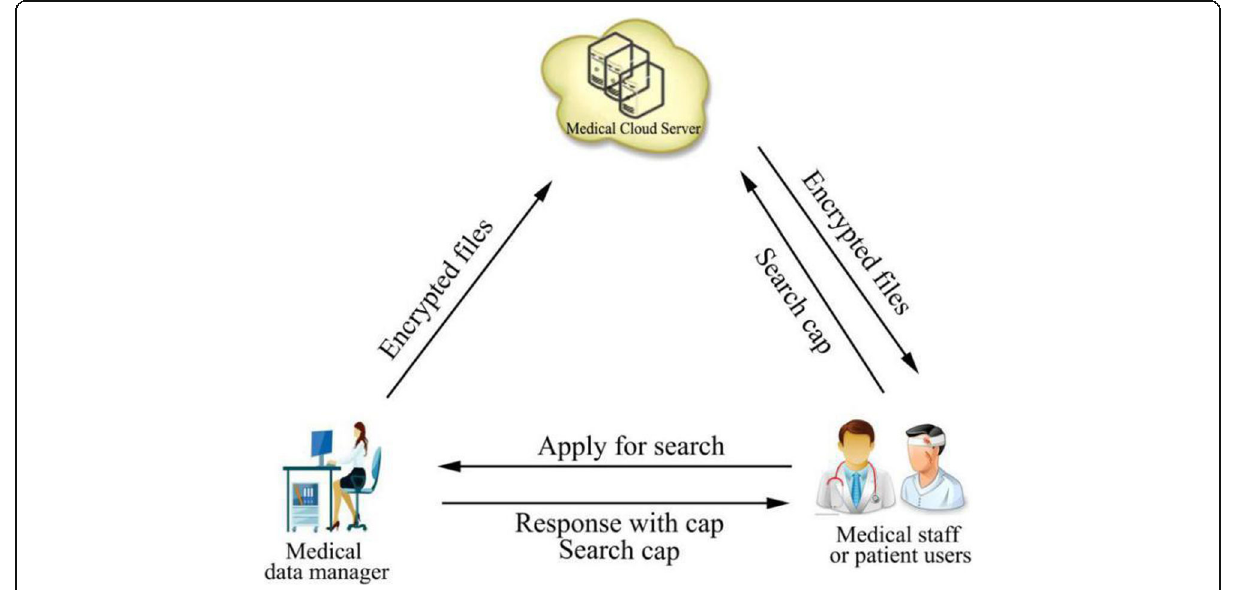
Fig. 2 The medical data owner generates search credentials and sends it to the patient